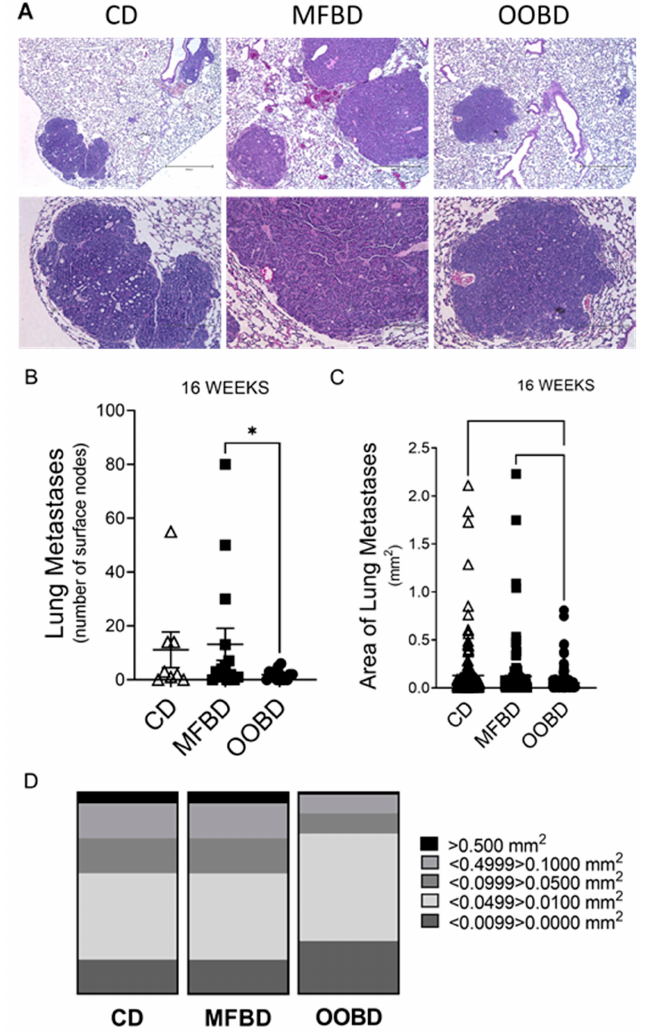
Figure 2. MFBD increases lung metastases in the MMTV-PyMT breast cancer model. ( A ) Representative images of hematoxylin and eosin (H&E) stained lung sections from MMTV-PyMT mice fed CD, MFBD, or OOBD. Upper panel magnification = 4x, scale bar = 600 µ m; lower panel magnification = 10x, scale bar = 250 µ m. ( B ) Quantification of the number of surface nodes on the lungs from 16-week-old MMTV-PyMT fed CD, MFBD or OOBD. Data represent mean ± SEM. Statistical analysis: Unpaired t -test, * p < 0.05, n ≥ 8 for each diet. ( C ) Quantification of the area of lung metastasis mice fed CD, MFBD, or OOBD. Data represent mean ± SEM. Statistical analysis: one-way ANOVA with a Dunn’s multiple comparison test, * p < 0.05, n = 4 for each diet. ( D ) Tumor size distribution represented as percent of